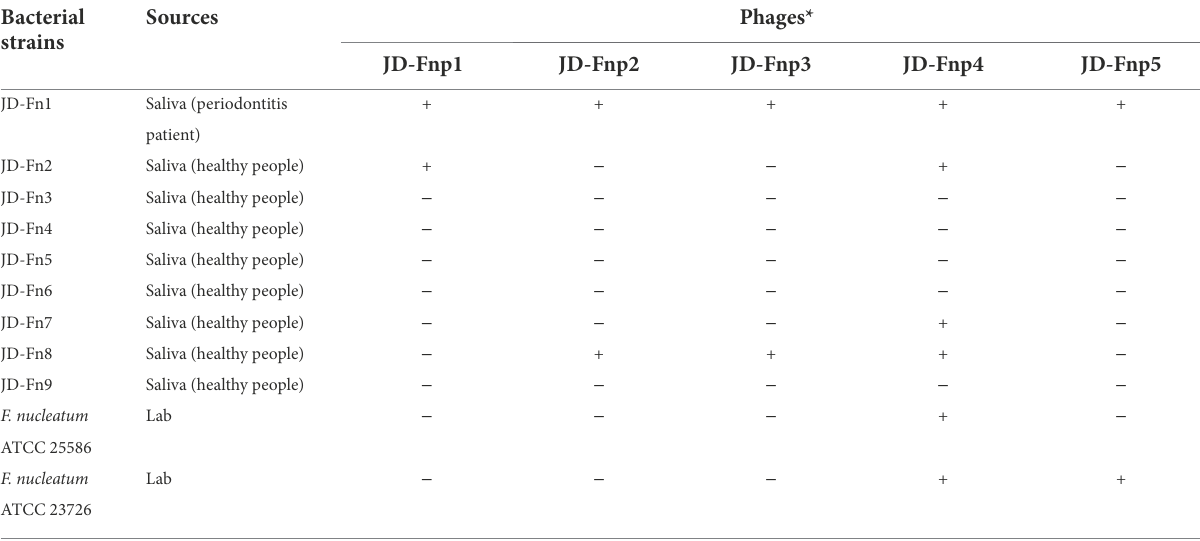
TABLE 1 Lytic spectra of JD-Fnp1 ~ JD-Fnp5 to 11 F. nucleatum strains. Bacterial